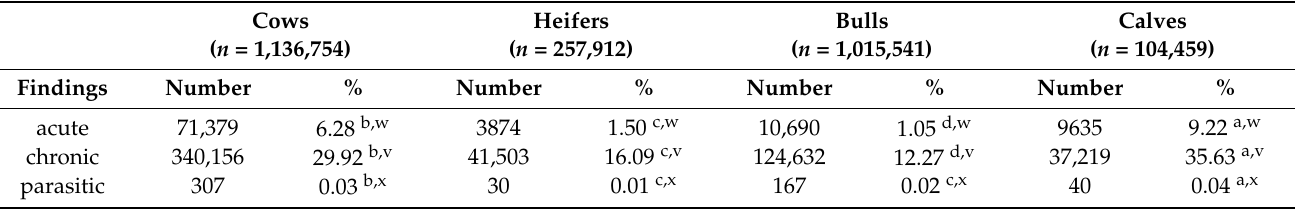
Table 3. Comparison of the incidence of pathological lung findings in cows, heifers, bulls and calves slaughtered in